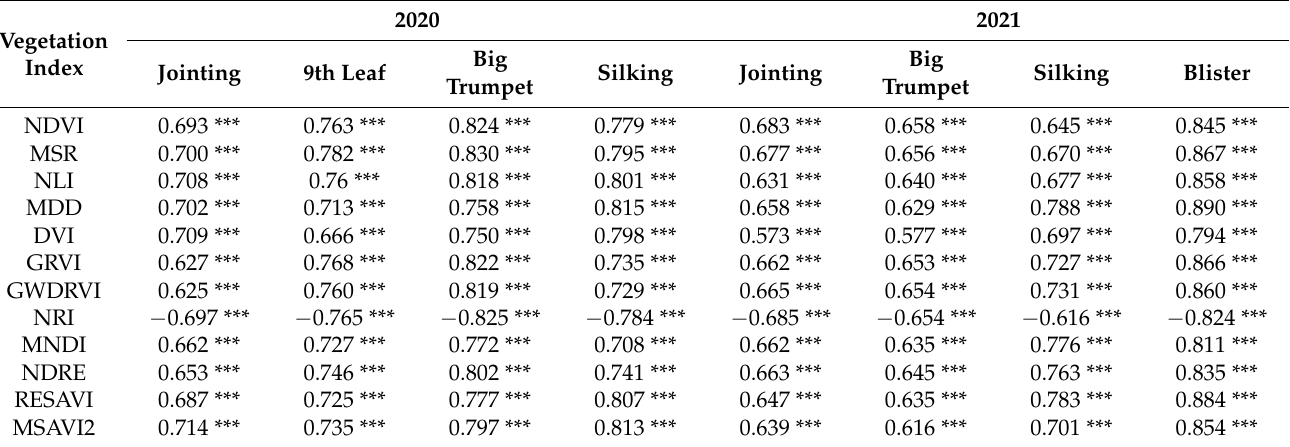
Table 5. Correlation between UAV-based vegetation indices and ground truth LAI.